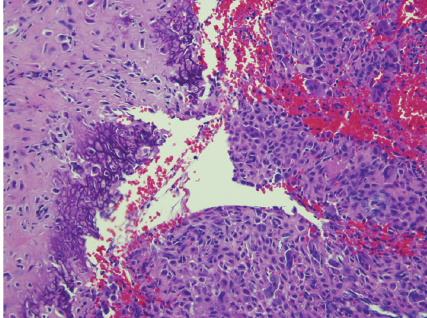
Figure 2: Mononuclear neoplastic cells with intermixed multinucleated giant cells (right), tumor cells surrounded by dark blue “chicken wire” calcifications (left center), and fibrochondroid islands (left) (hematoxylin and eosin stain, 20x